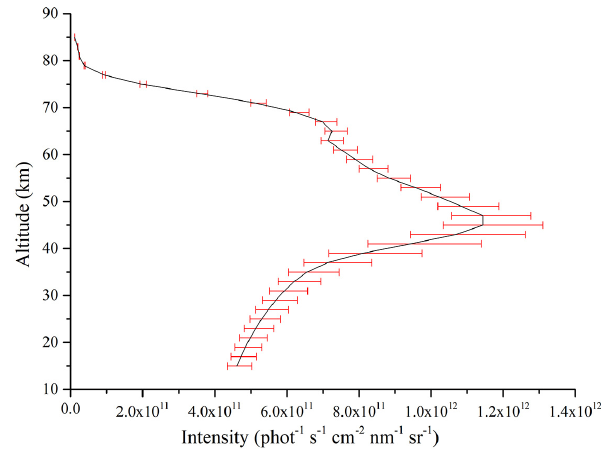
Figure 19. Relative errors in OH fluorescence emission radiance caused by the atmospheric model in the tomographic retrieval algo- rithm. The red error bars indicate the relative errors caused by the atmospheric